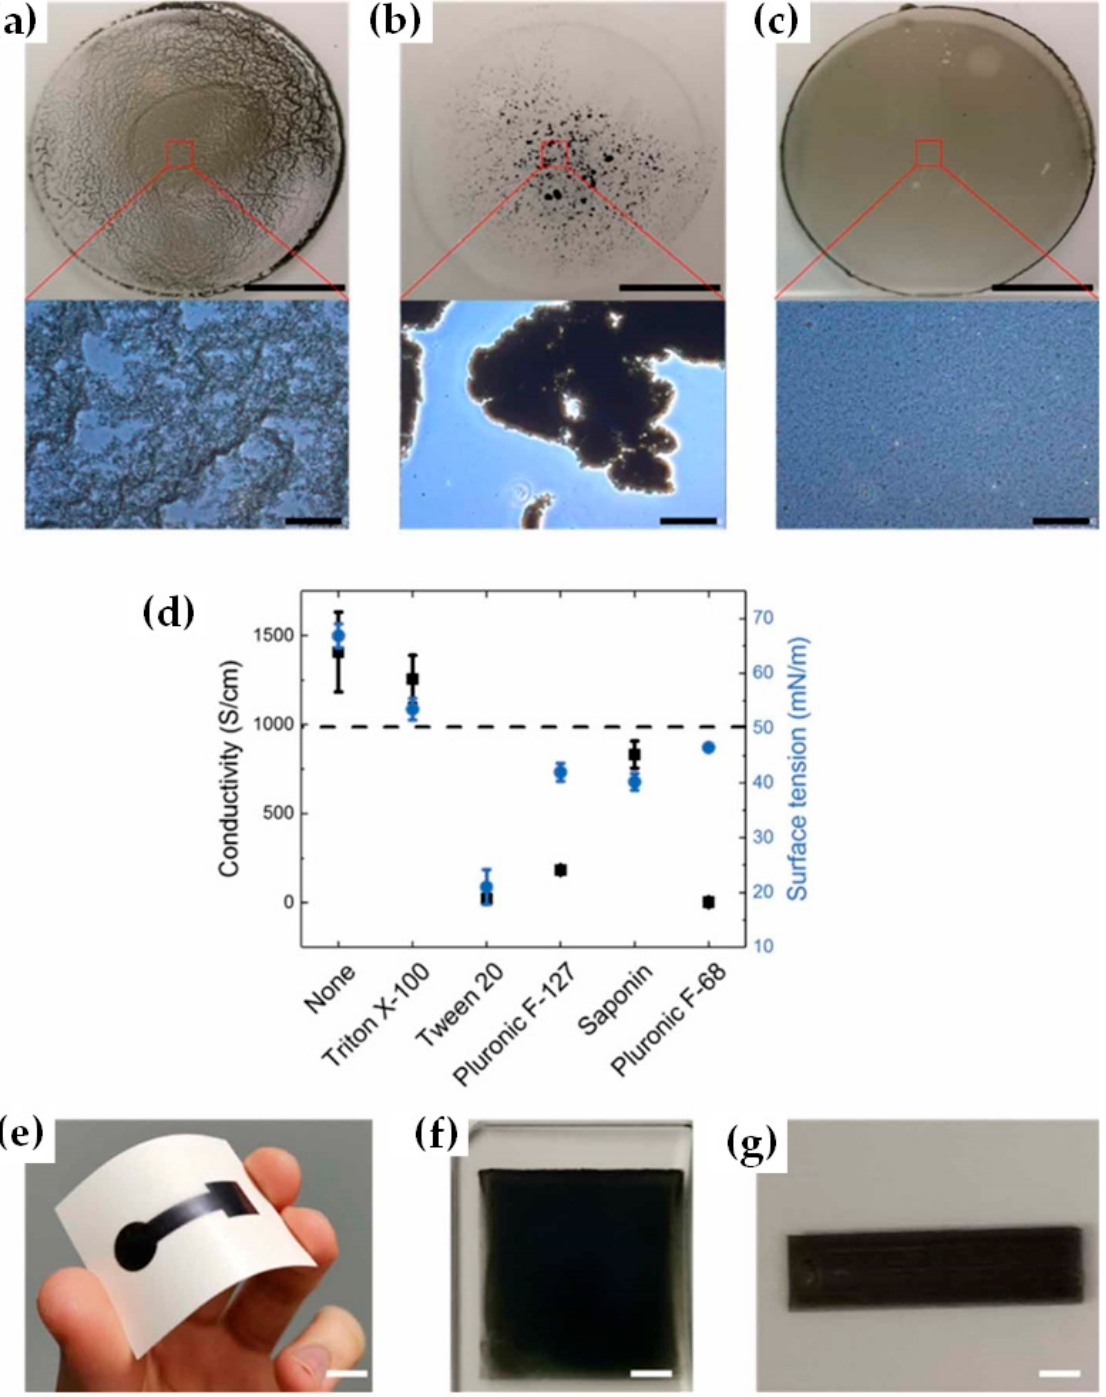
Figure 8. Optical photographs of MXene solutions comprising ( a ) an anionic and ( b ) a cationic surfactant, both creating heterogeneous suspensions. ( c ) MXene solution with a nonionic surfactant creates a homogeneous suspension. The bottom images are microscope images of the same suspen- sions. ( d ) The effect of surfactants on the surface tension of MXene inks and the conductivity of the resulting films (n = 3). Digital photographs of MXene films printed on various substrates: ( e ) tattoo paper, ( f ) glass and ( g ) a PEDOT:PSS coated glass substrate. Scale bars are 5 mm ( a – c top), 100 µ m ( a – c bottom), 1 cm ( e ), and 2mm ( f , g ), reprinted with permission from